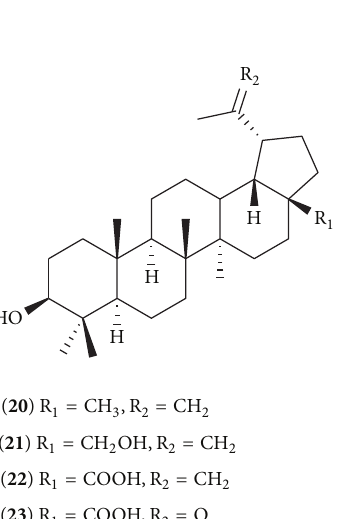
Figure 4: Rearranged triterpenoids.